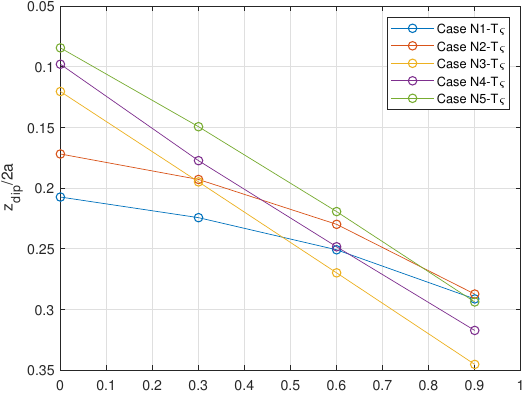
Figure 15. Propagation of the extent of the pressure dip depth ( z dip ) in the elastic medium beneath the center of the loaded area for the five combined normal-tangential loading cases and increasing shear ratio ς